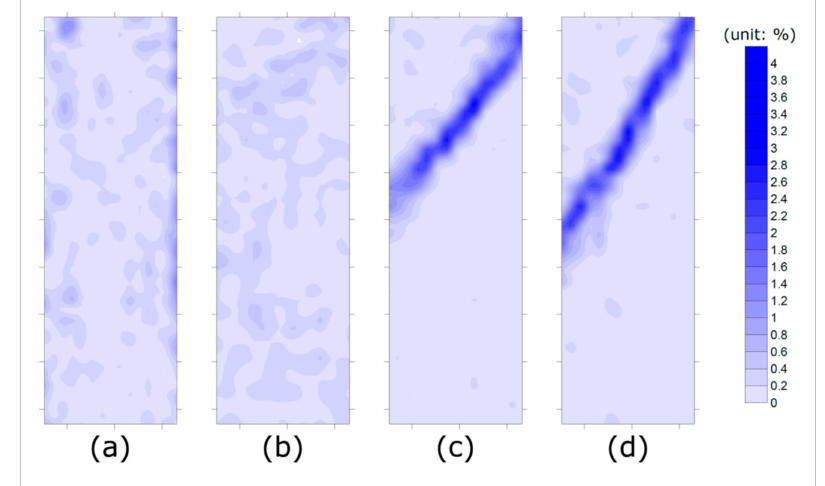
Figure 12. Increasing shear strain for NC1: ( a ) initial; ( b ) peak; ( c ) softening; and ( d ) steady